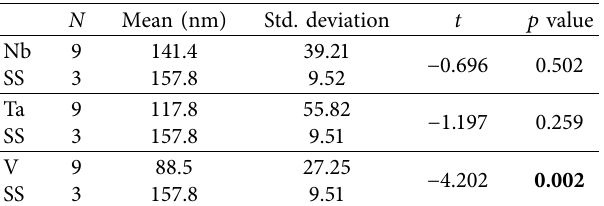
Te mean diference is signifcant at the 0.05 level. Te bold value indicates a signifcant statistical diference present between surface roughness of untreated 316L SS and coated substrates by V